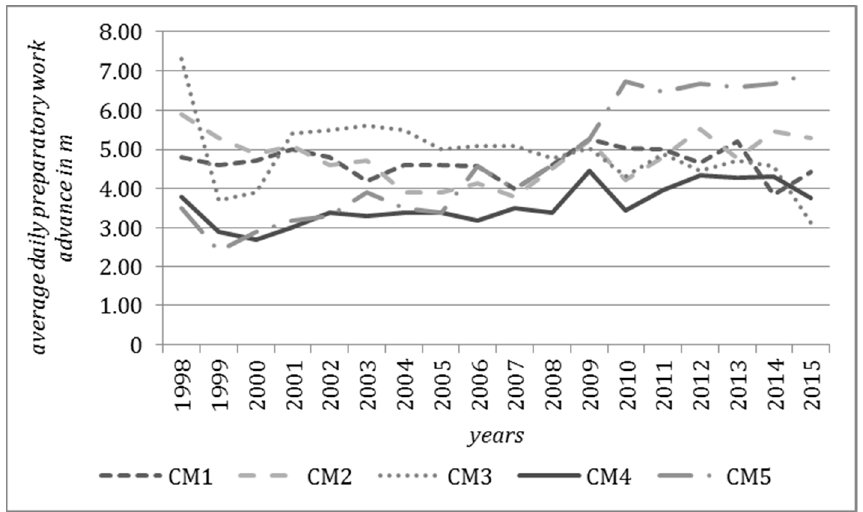
Figure 9. Average daily preparatory work advance in examined hard coalmines over the period 1998–2015 (m). Source: own work.